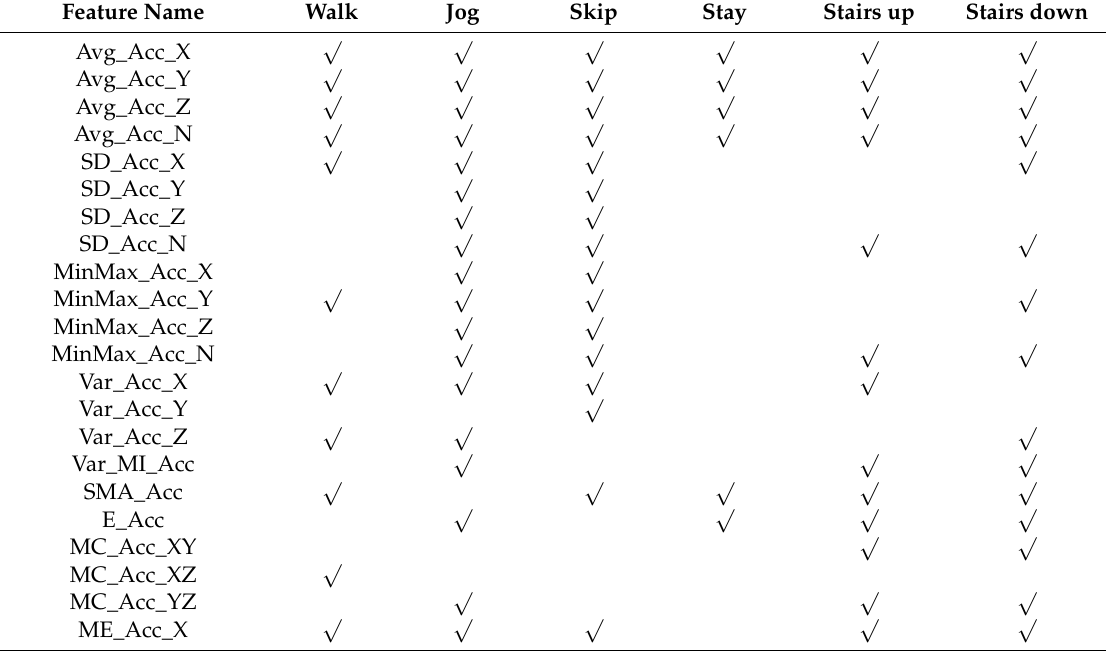
Table A2. List of selected features due to the different activity datasets in the accelerometer only